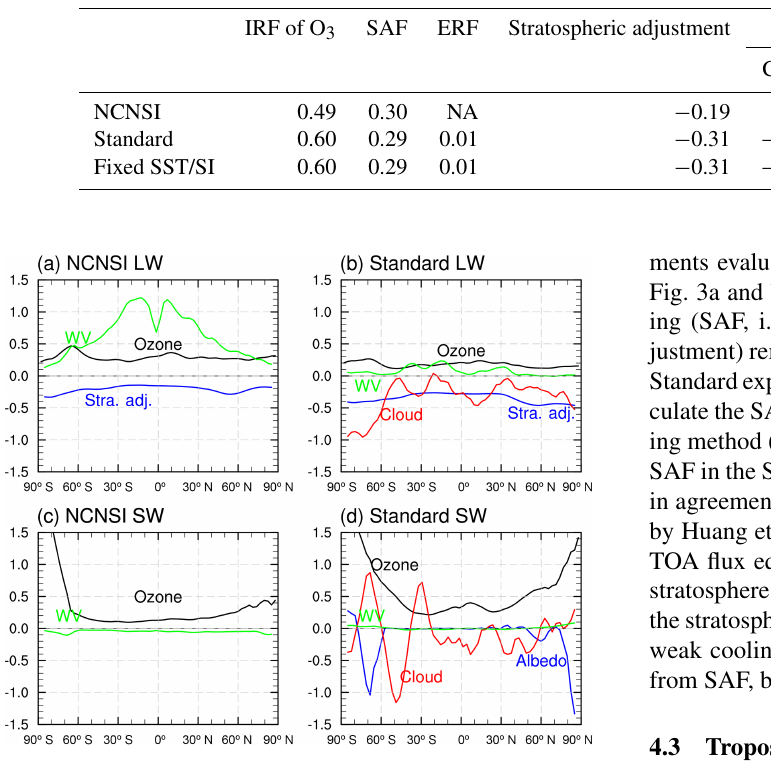
Figure 3. Annual and zonal mean distribution of the radiative con- tributions at TOA for the NCNSI experiment: (a) long-wave (LW) radiation: stratospheric temperature adjustment (blue line), ozone (black line), and water vapor (green line); (c) shortwave (LW) ra- diation: ozone (black line), and water vapor (green line). For the Standard experiment: (b) long-wave radiation: stratospheric adjust- ment (blue line), ozone forcing (black line), water vapor (green line), and radiative effect of cloud (red line); (d) shortwave radi- ation: ozone forcing (black line), water vapor (green line), cloud (red line), and ice-albedo (blue line) effects. Negative/positive val- ues indicate upward/downward radiative flux at TOA. The radiative forcing of ozone is calculated with